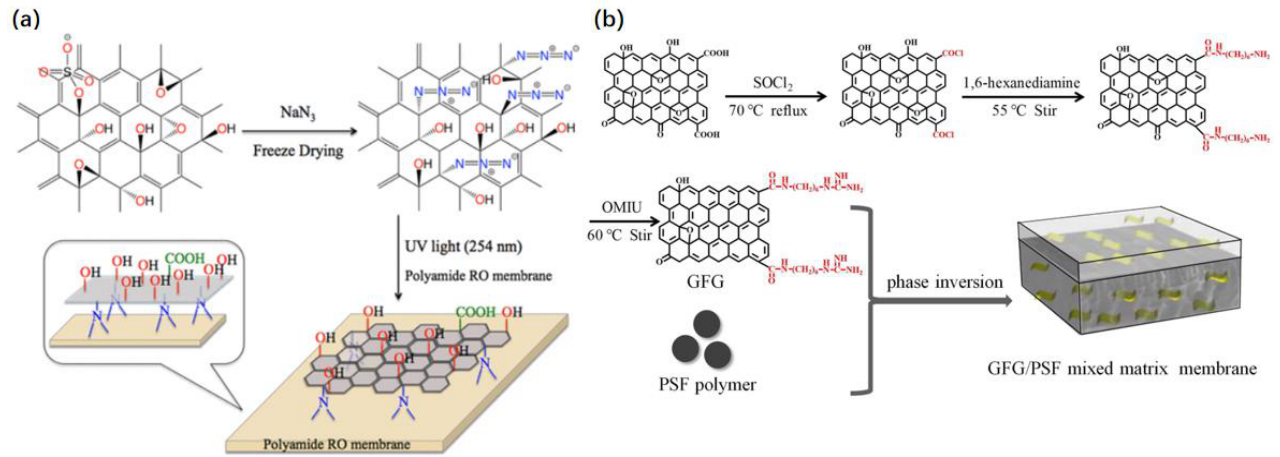
Figure 6. ( a ) Synthesis of AGO and its UV activation on the surface of PA reverse osmosis membrane. (Printed image with permission from Ref. [109], copyright 2016, American Chemistry Society). ( b ) Synthetic route of GFG/PSF mixed matrix membrane. (Printed image with permission from Ref. [113], copyright 2019, Elsevier Ltd.).